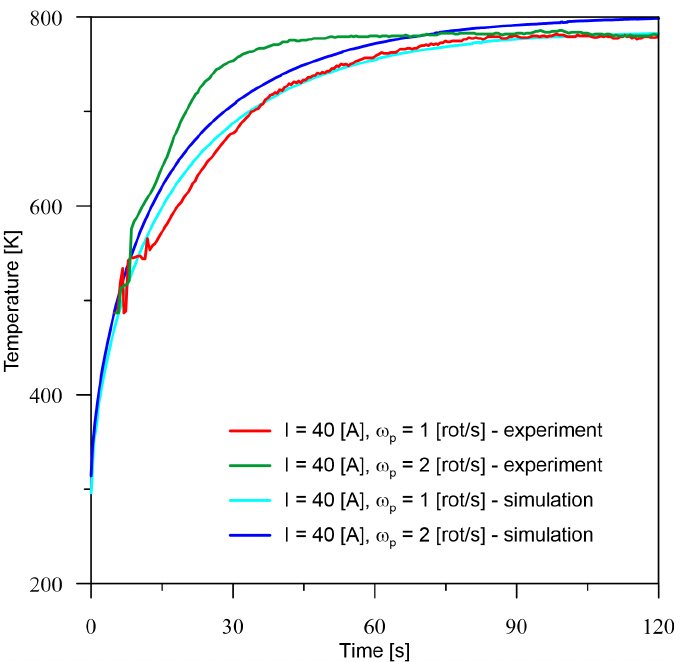
Figure 4. Comparison of the results of the experiment and the numerical model for I = 40